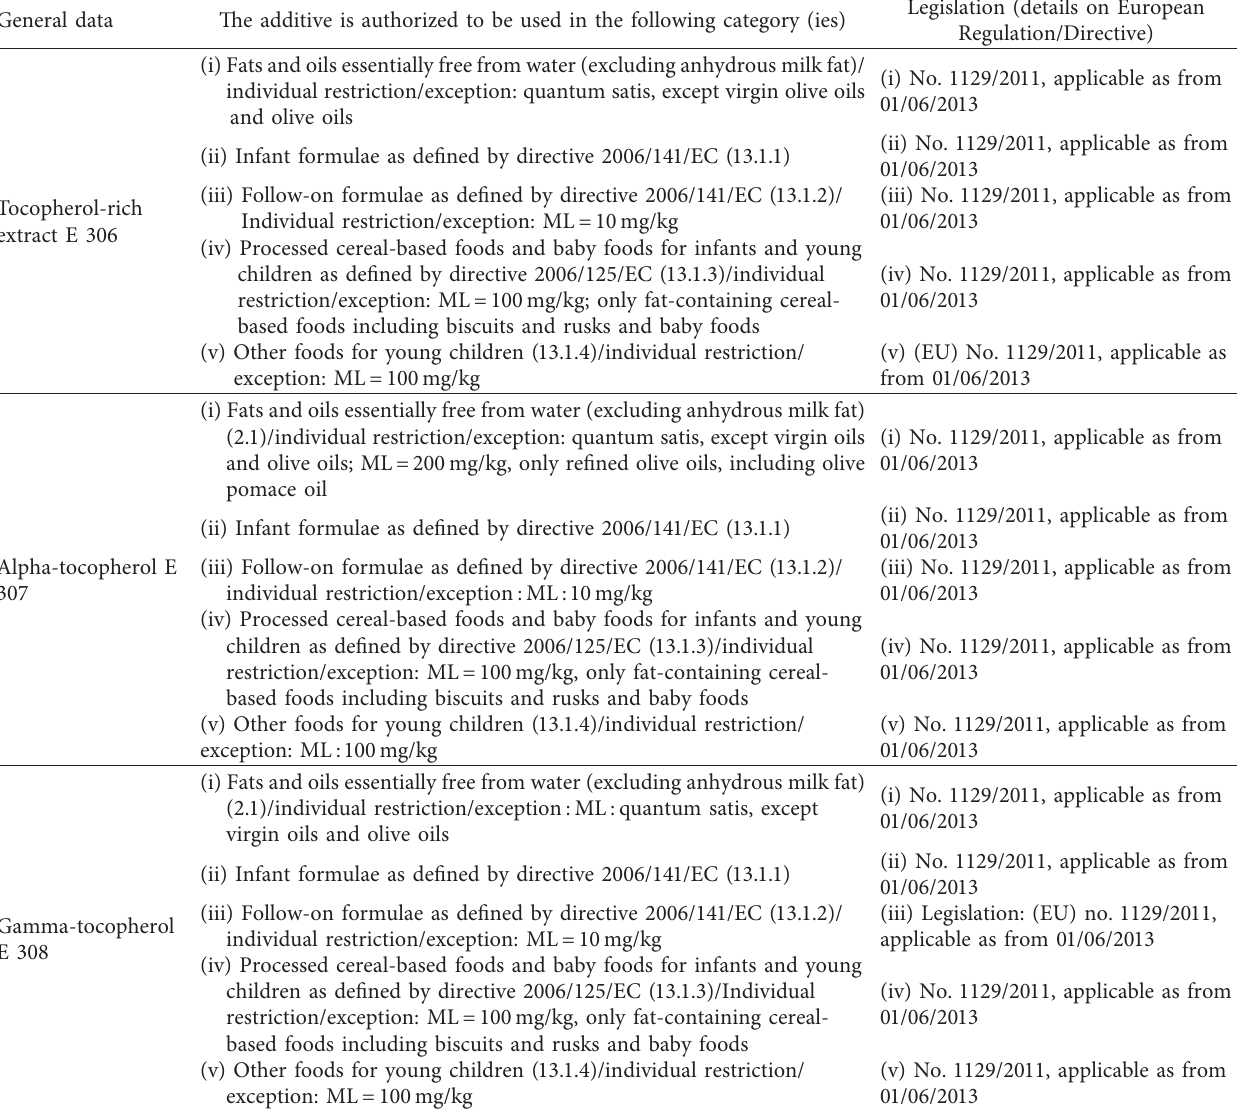
Table 3: Use of tocopherols as food additives in accordance with European legislation. General